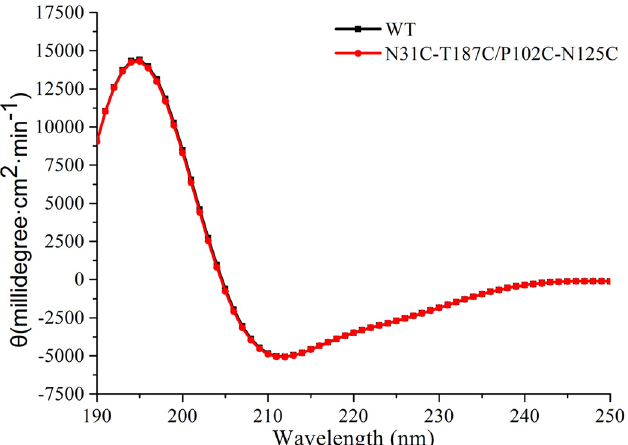
Fig 4. Comparison of CD spectra of wild-type BglTM and N31C-T187C/P102C-N125C mutant in 20 mM phosphate buffer